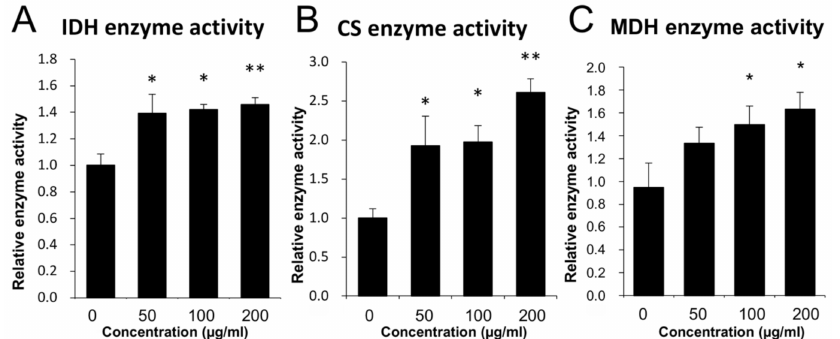
Figure 2. The effects of chlorogenic acid on mitochondrial enzyme activity in HepG2 cells. Confluent cultures of HepG2 cells were cultured with DMEM. Thereafter, different concentrations of chlorogenic acid were added and cells were cultured for 24 h. The enzyme activities of ( A ) isocitrate dehydroge- nase (IDH), ( B ) citrate synthase (CS), and ( C ) malate dehydrogenase (MDH) were measured. The data are shown as mean ± SE ( n = 4). * p < 0.05, ** p < 0.01 vs. control